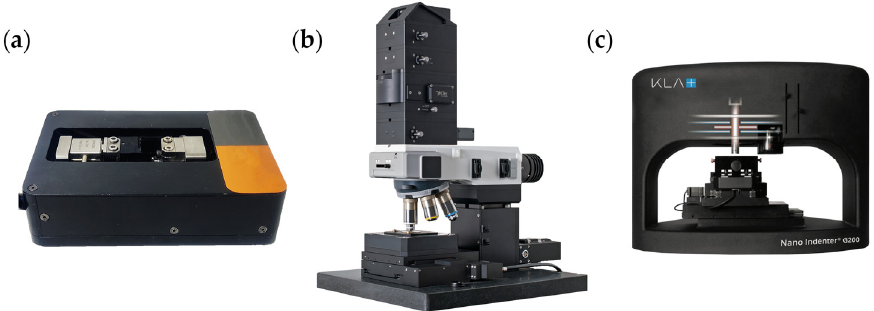
Figure 1. ( a ) Miniature in situ mechanics tester; ( b ) laser confocal micro-Raman spectrometer; ( c ) nanoindentation instrument.